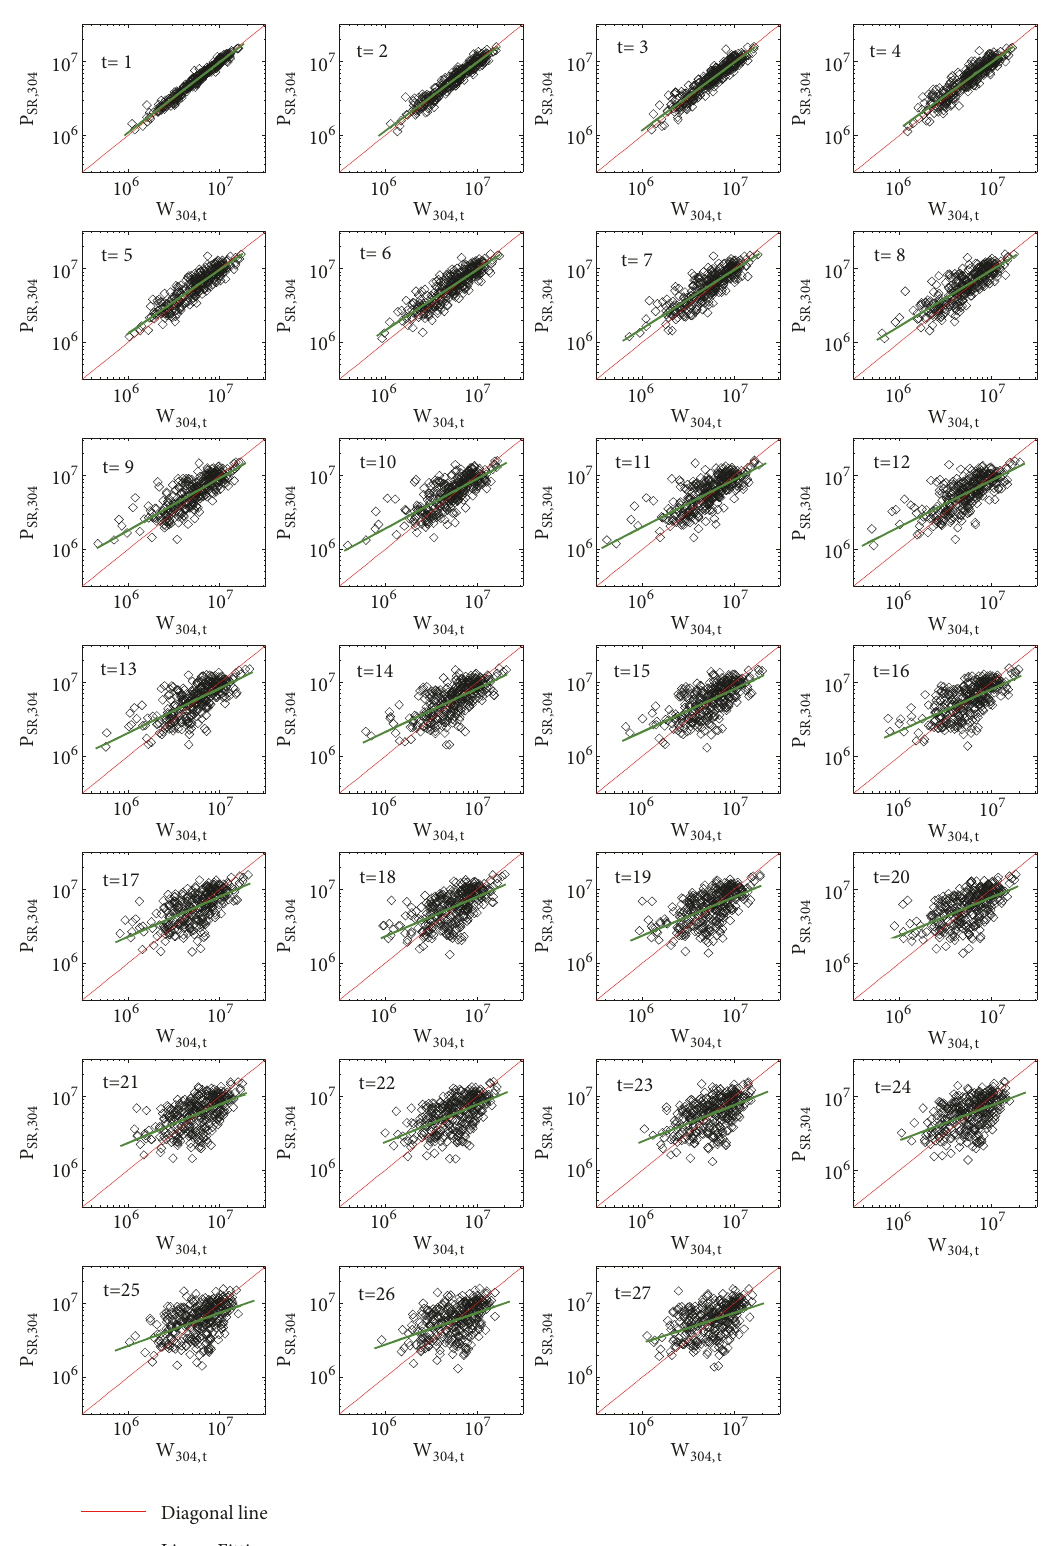
Figure 5: Scatter diagrams between W 304, t and P SR ,304 before 27 March 2013. The solid red line is the diagonal line, and the solid green line is the fitting